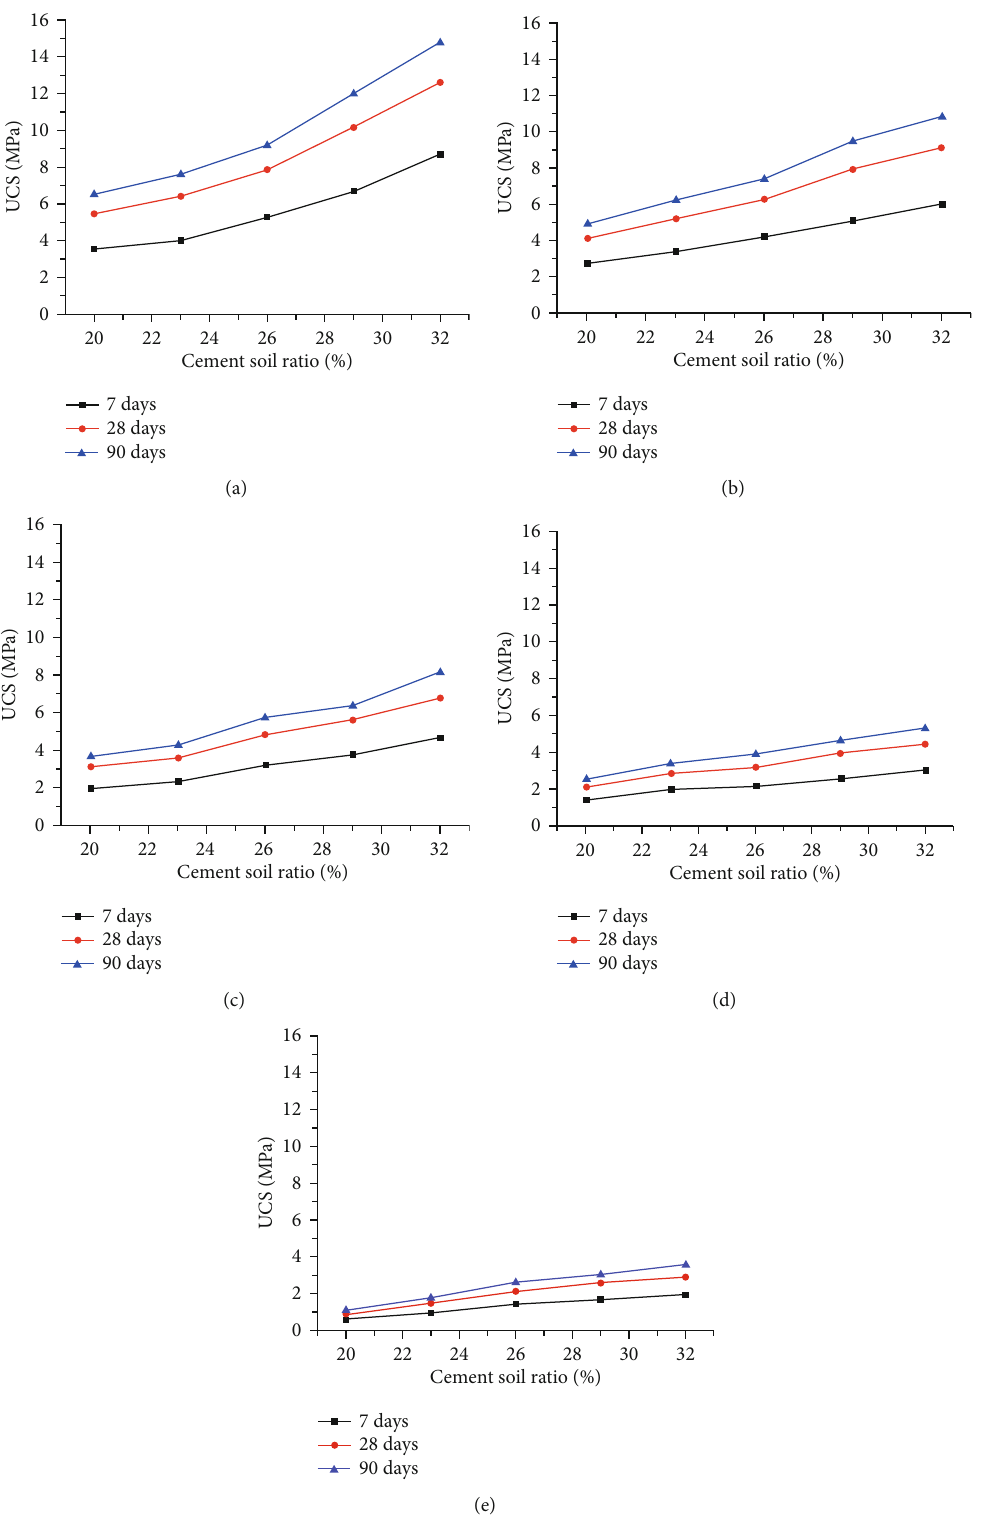
Figure 8: Curve of uncon fi ned compressive strength with cement soil ratio. (a) Moisture content 28%. (b) Moisture content 33%. (c) Moisture content 385. (d) Moisture content 43%. (e) Moisture content